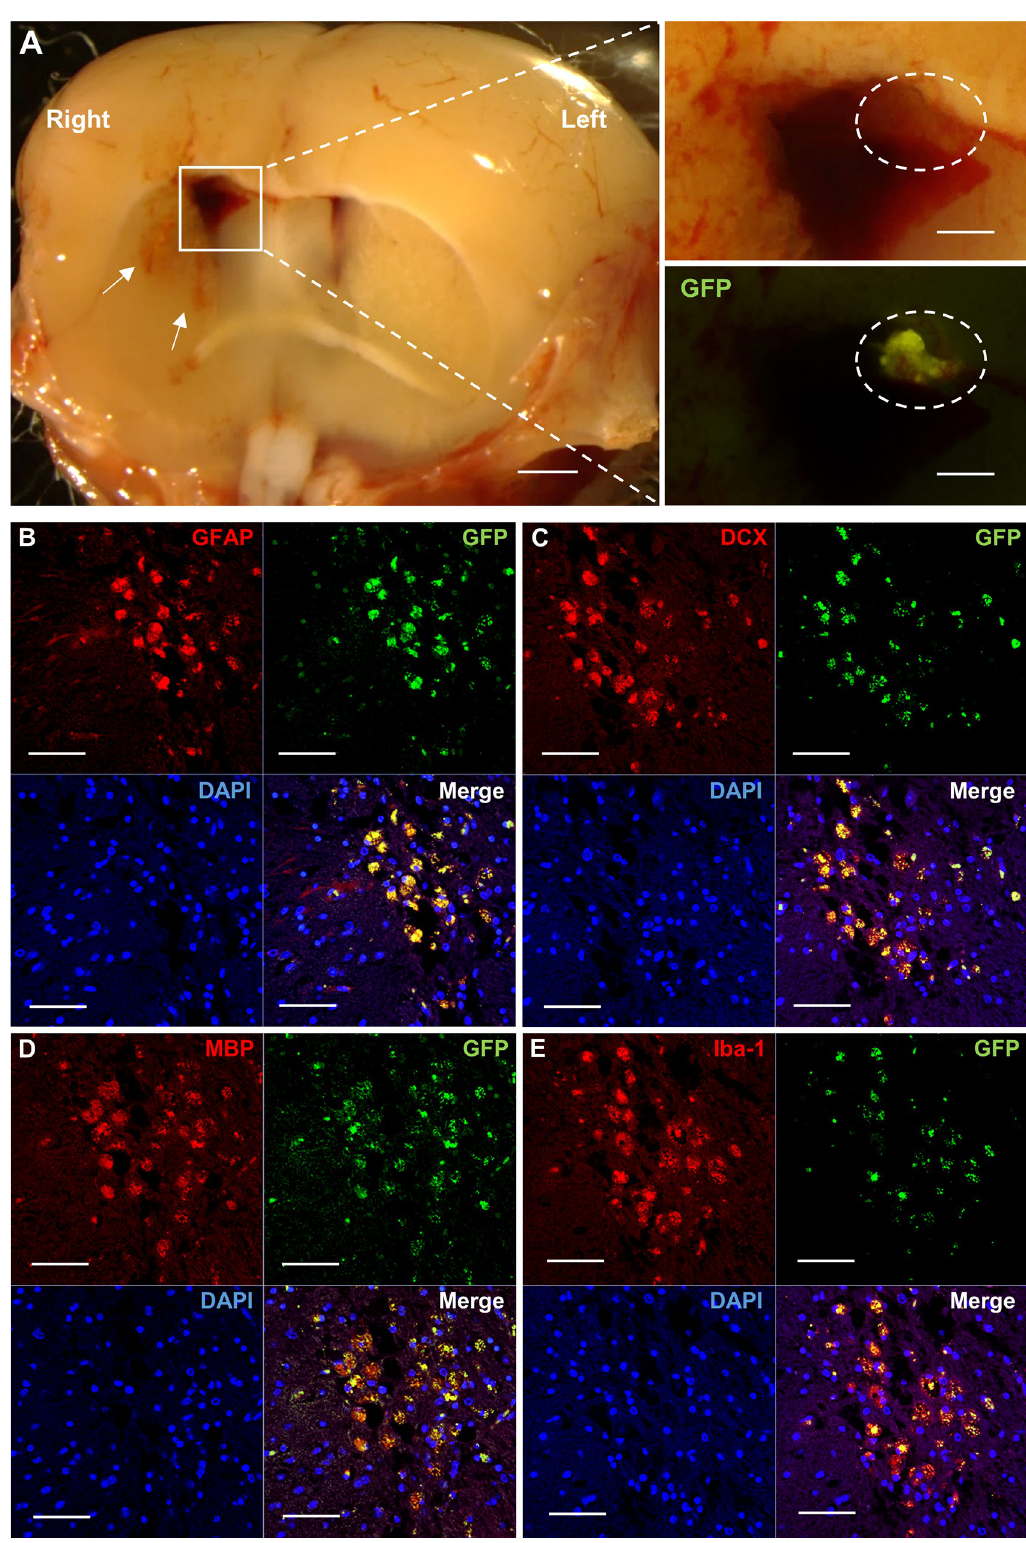
Fig 2. Implanted HAP stem cells repair the ICH site in nude mice. (A) Stereomicroscopy shows that GFP-expressing HAP stem cells repaired the ICH lesion. White arrow indicates hemorrhage in the striatum. White square line indicates hematoma in the brain. White dotted line indicates transplanted HAP stem cells from GFP mice in the hematoma. Left panel = low- magnification of coronal section at ICH. Bar = 1mm. Right panel = high-magnification of white square line area. Bar = 500 μ